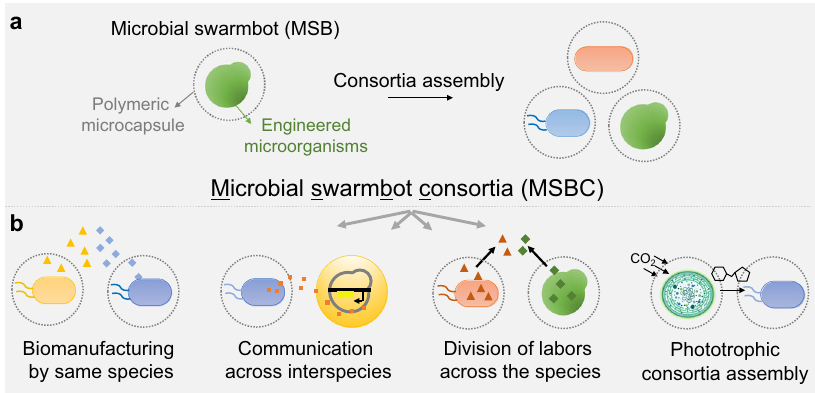
Fig. 1 Engineering microbial consortia with polymeric microbial swarmbots. a Engineering stably coexisting consortia by microbial swarmbot mediated spatial segregation strategy. Each microbial swarmbot (MSB) consists of a small population of engineered microbes encapsulated in polymeric microcapsules. The MSBs containing different subpopulations are then co-cultured to form the microbial swarmbot consortia (MSBC). Polymeric capsules insulate populations in different MSB. Therefore, members of the consortium, even with a mismatched growth rate, can grow in balance due to a relevantly independent growth space and de fi ned carrying capacity of the microcapsules. b MSBC strategy enables diverse applications. MSBC method can construct versatile consortia for diverse applications. For example, MSBC (single species) can collectively manufacture multienzyme system. Members of the MSBC (across the species) can communicate or collaborate (division of labor). Phototrophic MSBC can transform the carbon dioxide into the carbon source by phototrophic members to maintain the growth of the heterotrophic